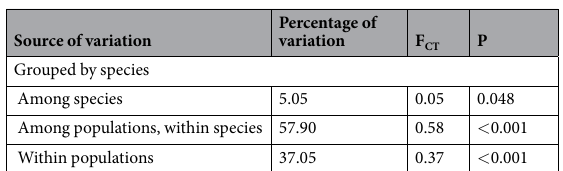
Source of variation Grouped by species Among species Among populations, within species 57.90 Within populations Table 3. Results of AMOVA grouped by the three species based on Cytb sequences.